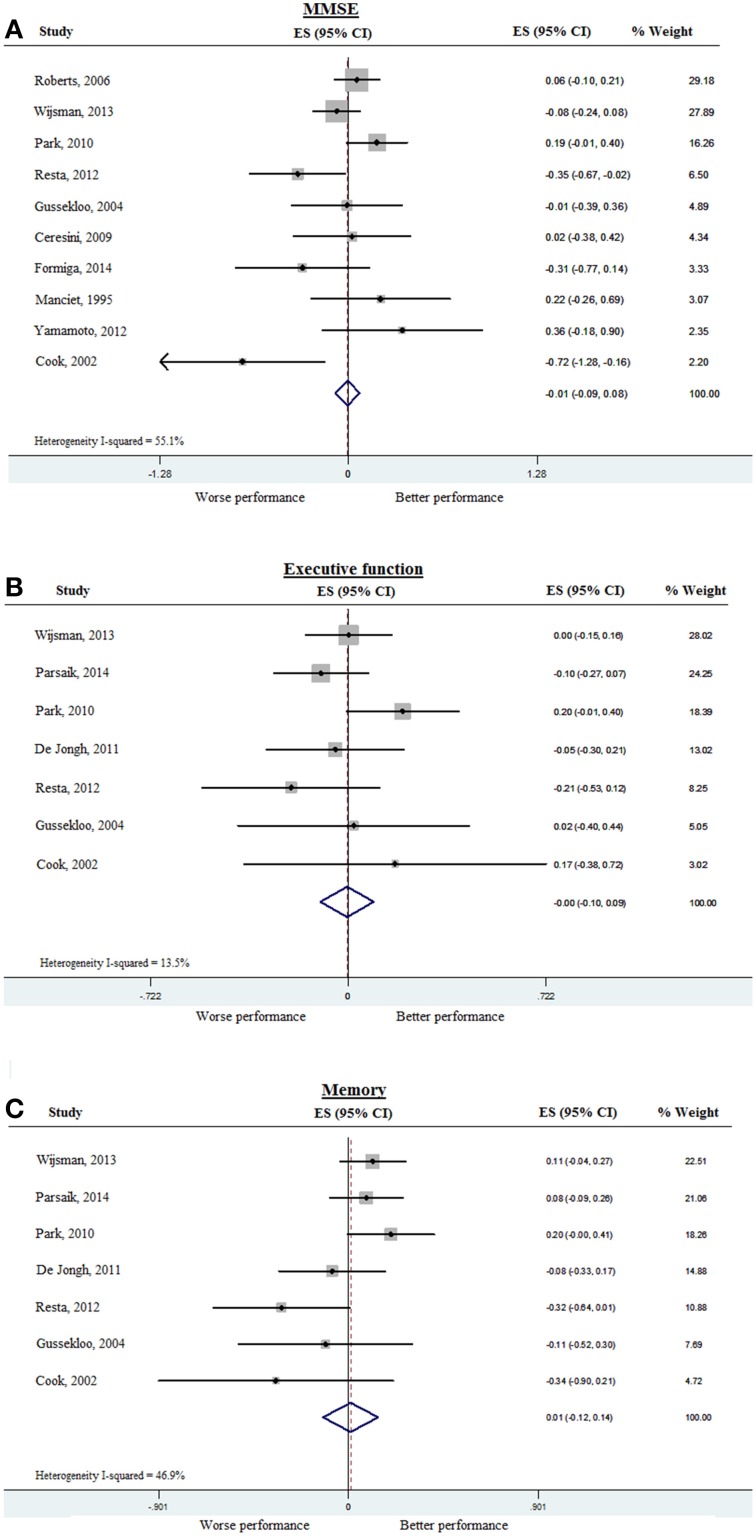
Forest plots depicting the cross-sectional associations observed between subclinical hypothyroidism (compared to controls) and cognitive performance in 10 studies, arranged according to the weight of the studies. Data was pooled from cross-sectional studies and baseline data of prospective studies. (A) Association between subclinical hypothyroidism and global cognition as measured by MMSE, (B) Association between subclinical hypothyroidism and executive function, and (C) Association between subclinical hypothyroidism and memory. The pooled effect sizes are displayed as diamonds. MMSE, Mini-mental state examination.